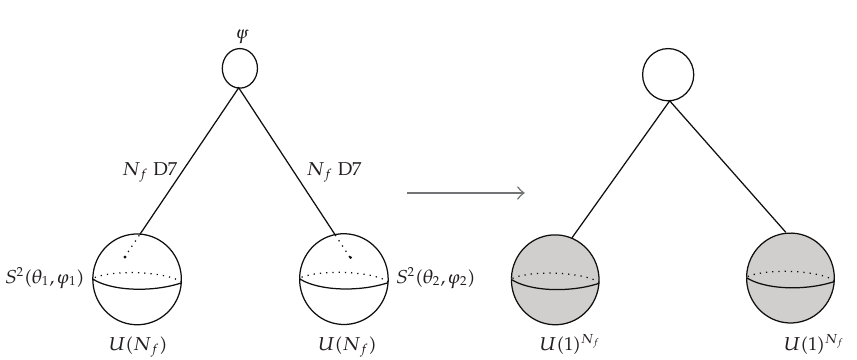
Figure 4: We see on the left side the two stacks of N f flavor-branes localized on each of their respective S 2 ’s (cid:5) they wrap the other S 2 (cid:6) . The flavor group is clearly U (cid:5) N f (cid:6) × U (cid:5) N f (cid:6) . After the smearing on the right side of the figure, this global symmetry is broken to U (cid:5) 1 (cid:6) N f − 1 × U (cid:5) 1 (cid:6) N f − 1 × U (cid:5) 1 (cid:6)